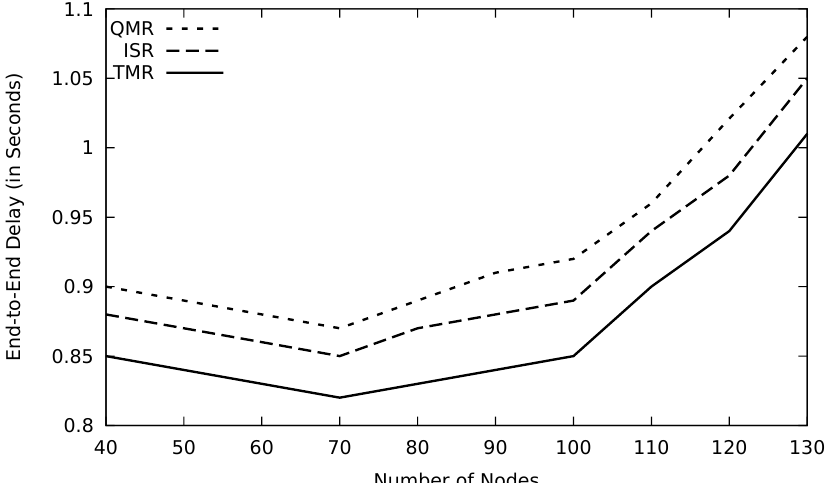
Figure 34. Comparison of QMR, ISR, and proposed protocol TMR for end-to-end delay with number of nodes.